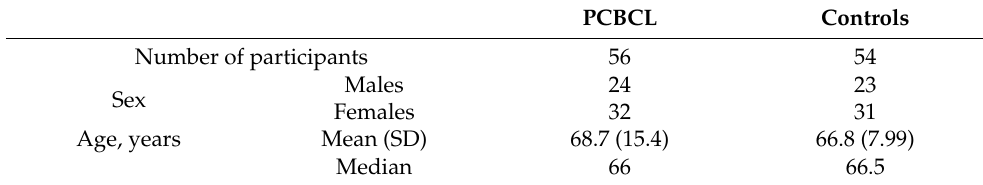
Table 1. Demographic characteristics of cases and control